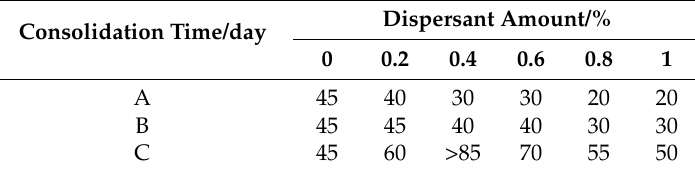
Table 5. The Consolidation results of three